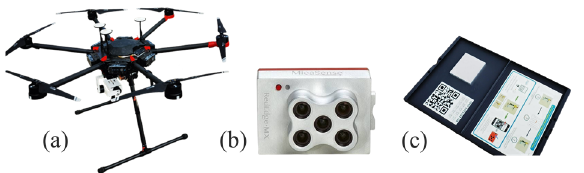
Figure 2. UAV multispectral remote sensing platform: ( a ) the UAV system ( b ) the multispectral camera ( c ) the calibration plate.